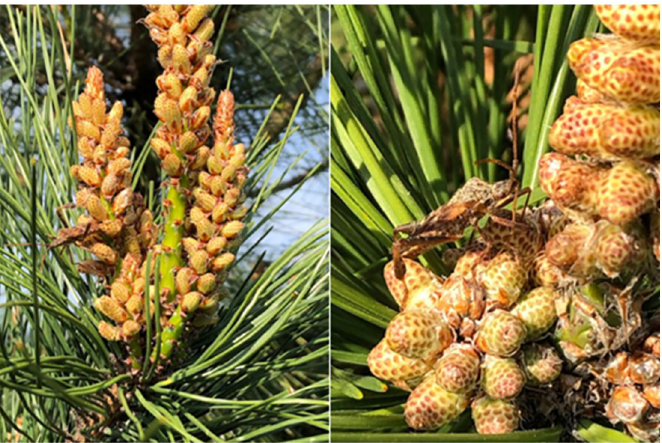
Fig 1. Western conifer seed bug (WCSB) holding on to male cones. These pictures were taken on 8 April